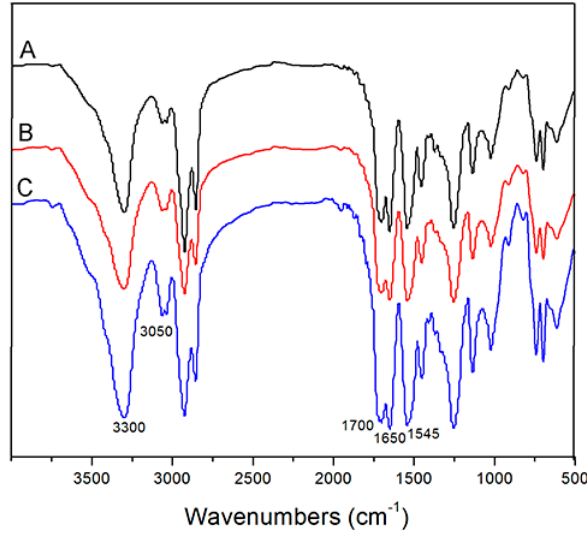
Figure 3. FT-IR spectra of PE- b -PZL copolymers: ( A ) PE 607 - b -PLL 97 ; ( B ) PE 607 - b -PLL 188 ; and ( C ) PE 607 - b -PLL 275 .